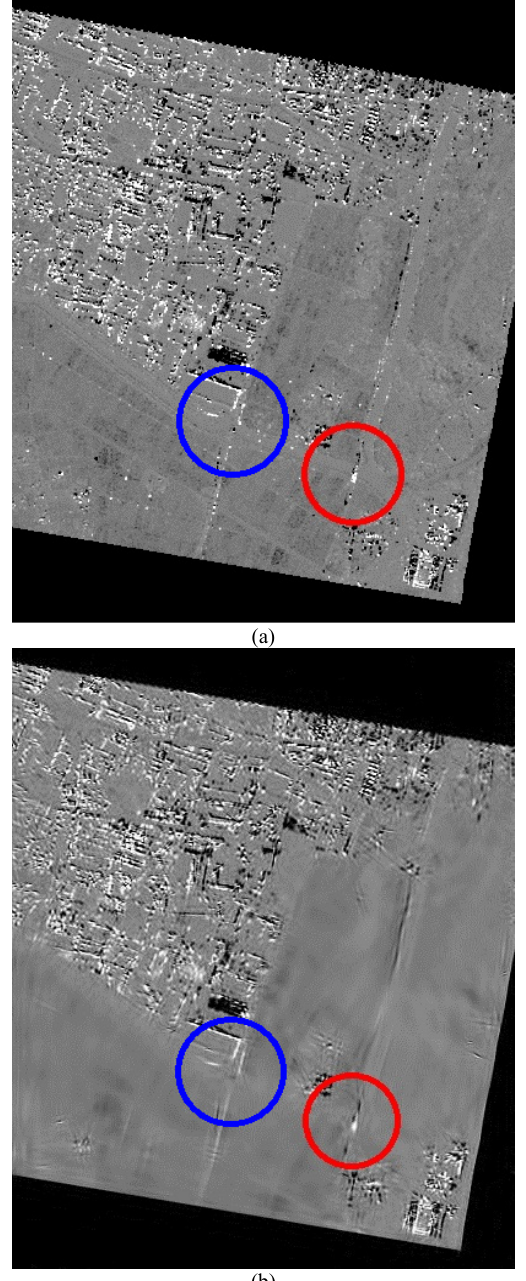
(b) Figure 11. (a) The (stretched) difference image of the pre- and post-event TSX images within the study area (Figure 8). (b) The difference image shown in (a) after Curvelet filtering. The blue and red circles indicate the locations of To and Fujisonetaishi Bridges